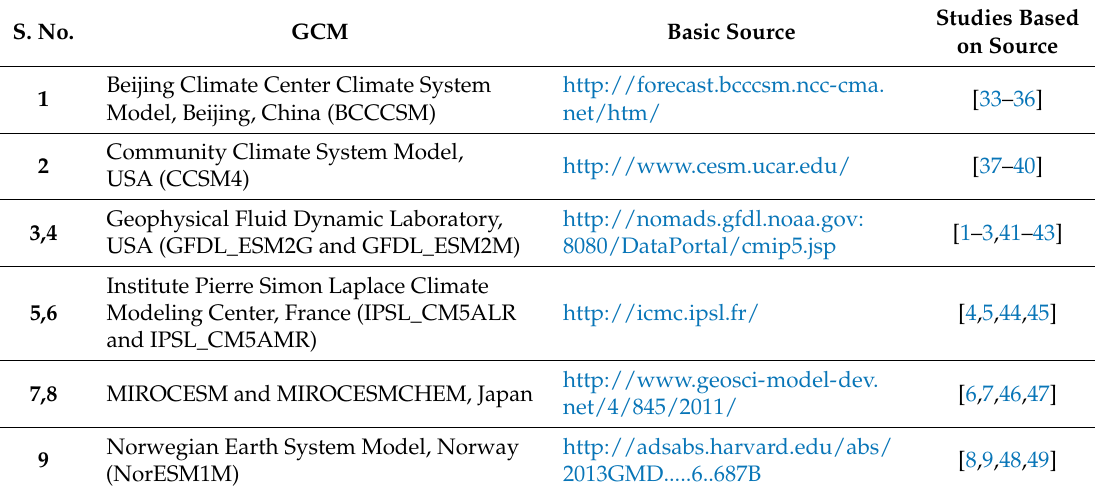
Table 1. Different GCM models used for quantifying the error or bias when compared with the ground-based station from NOAA’s (National Oceanic and Atmospheric Administration) Climate Data Online